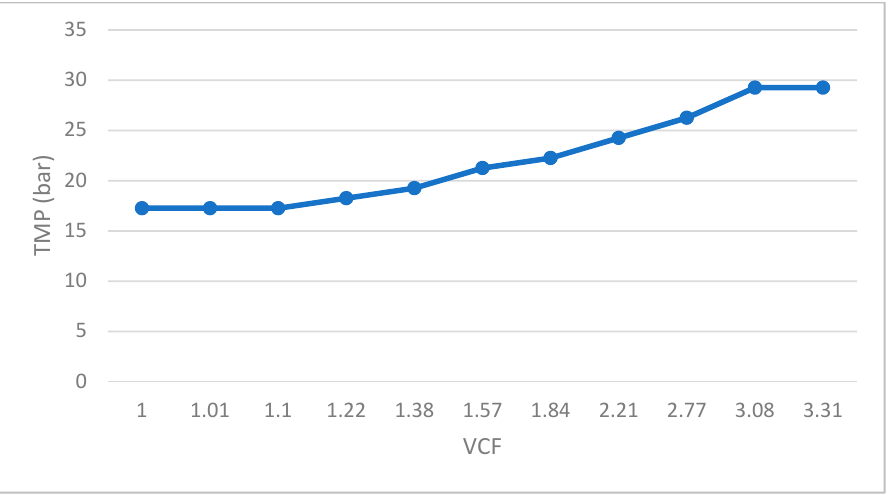
Figure 8. Changes in TMP related to variations of VCF over the duration of the reverse osmosis filtration pilot test.